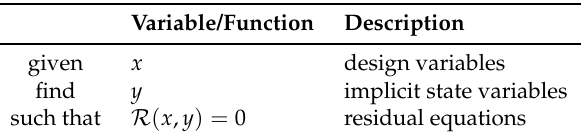
Table 2. Solver problem formulation.